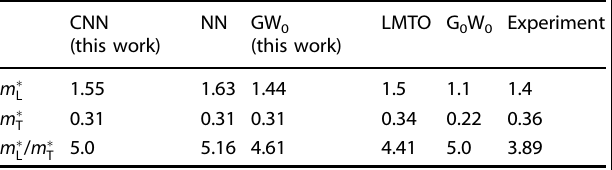
Table 1. Longitudinal and transverse electron effective masses at CBM in undeformed diamond (in units of free-electron stationary mass m e